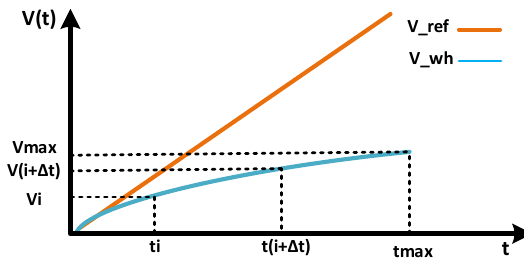
Figure 3. Synthetic acceleration